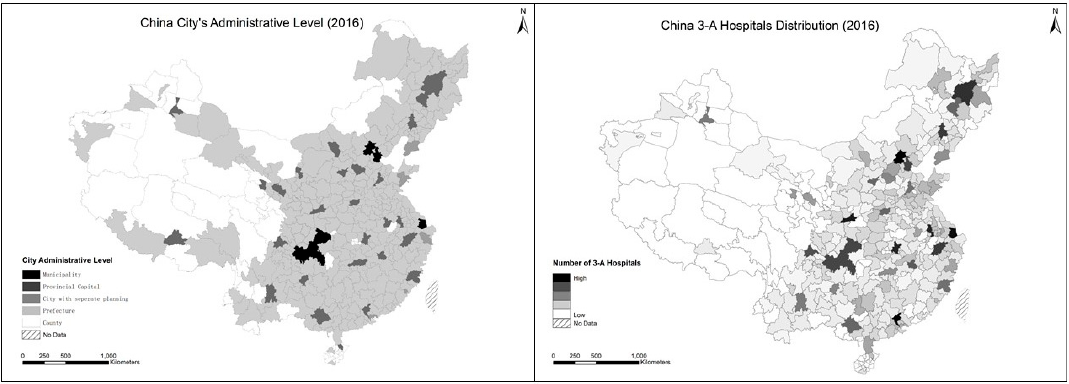
Figure 2. China City’s Administrative Level vs. 3-A Hospitals Distribution. Source: Compiled by authors.